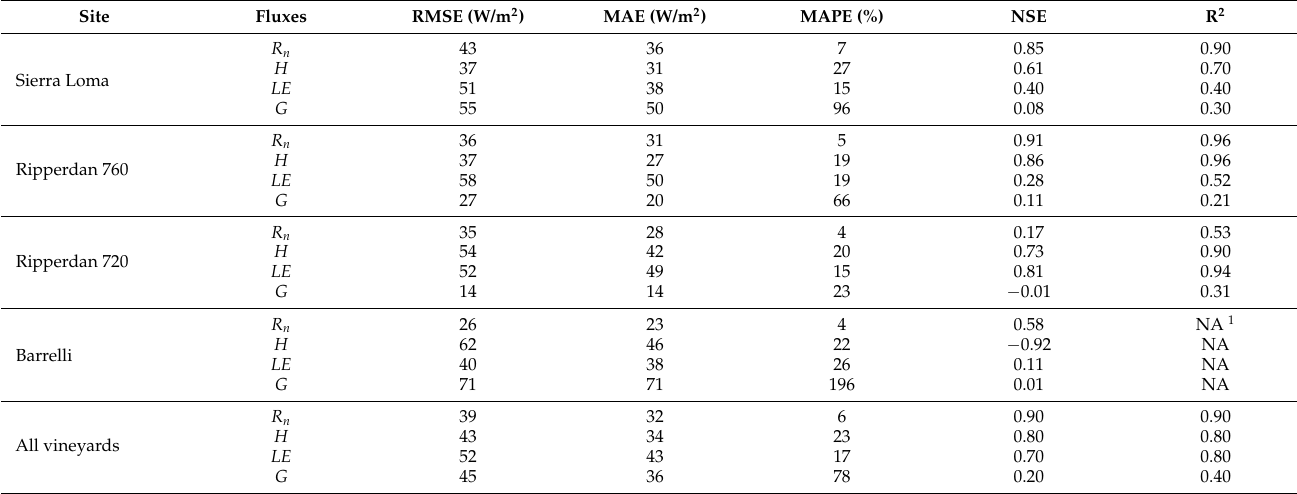
Figure 7. Comparison of instantaneous TSEB sUAS energy fluxes against EC measurements (without flux closure). The presented subplots include the available sUAS imagery, as described in Table 1. Table 4. Goodness-of-fit statistics between the eddy covariance ( EC ) and the instantaneous TSEB sUAS fluxes at the different vineyard sites of this